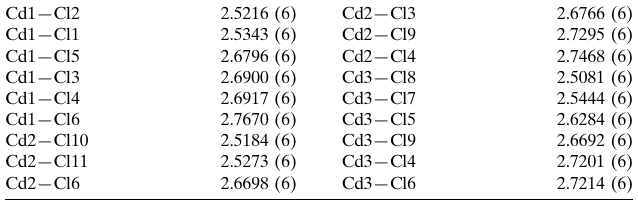
Selected bond lengths (A˚ ).